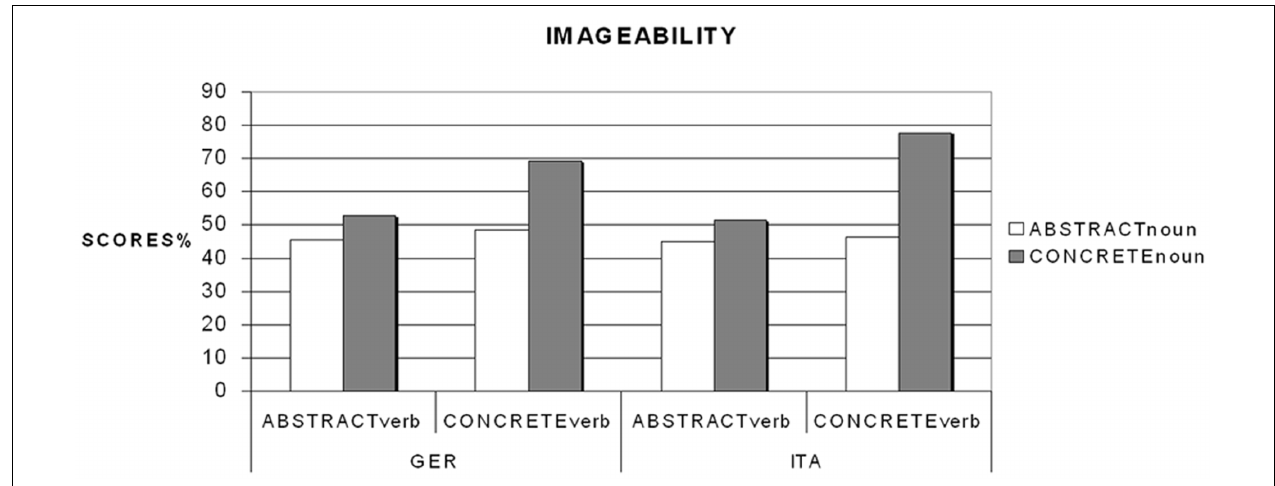
FIGURE 1 | German and Italian participants had the same pattern: the pair containing both words concrete was judged as the easiest to imagine. Moreover for both groups the noun was stronger than the verb in determining the imageability of the sentences.